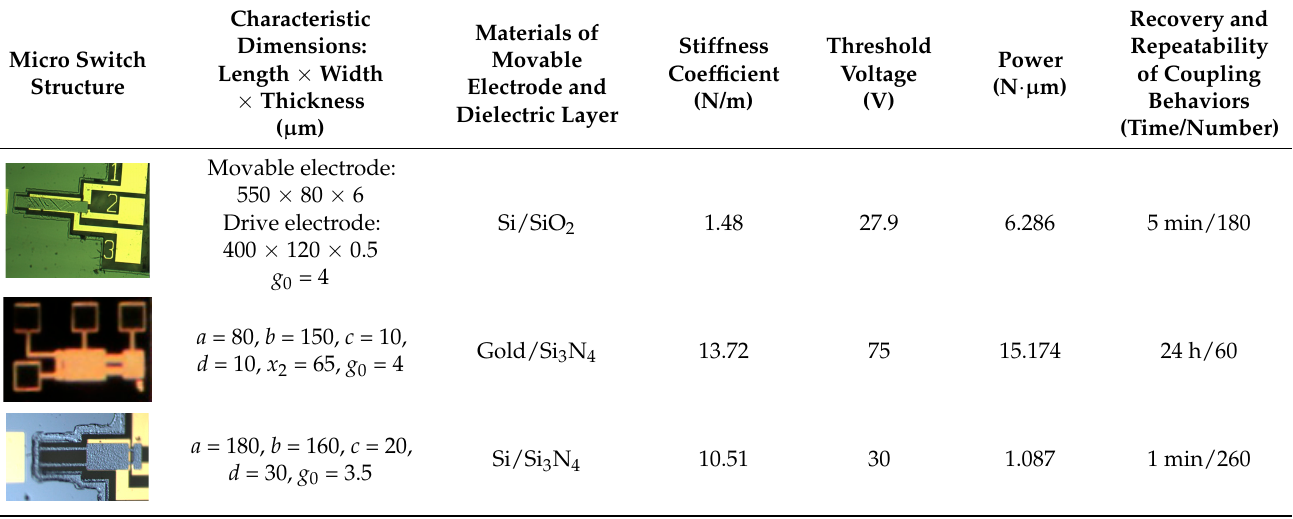
Table 6. Characteristics of inertial micro-switch with multi-threshold acceleration.